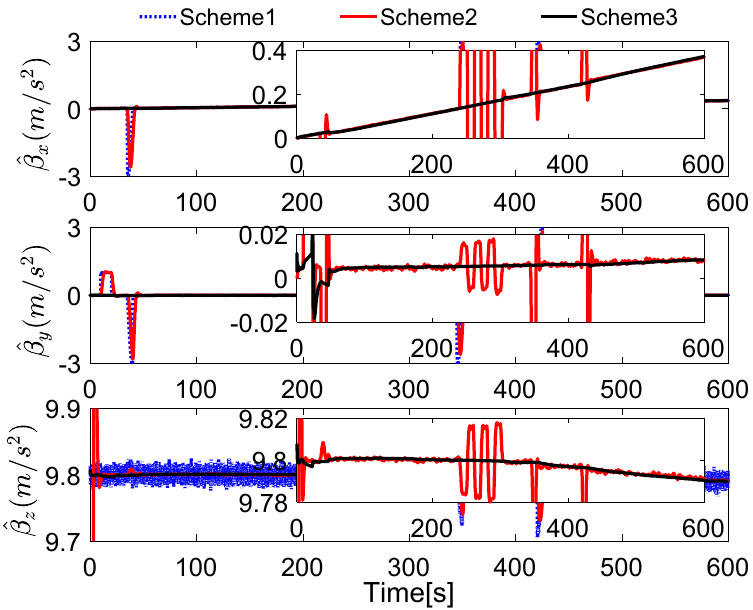
Figure 11. Curves of the reconstructed observation vectors.